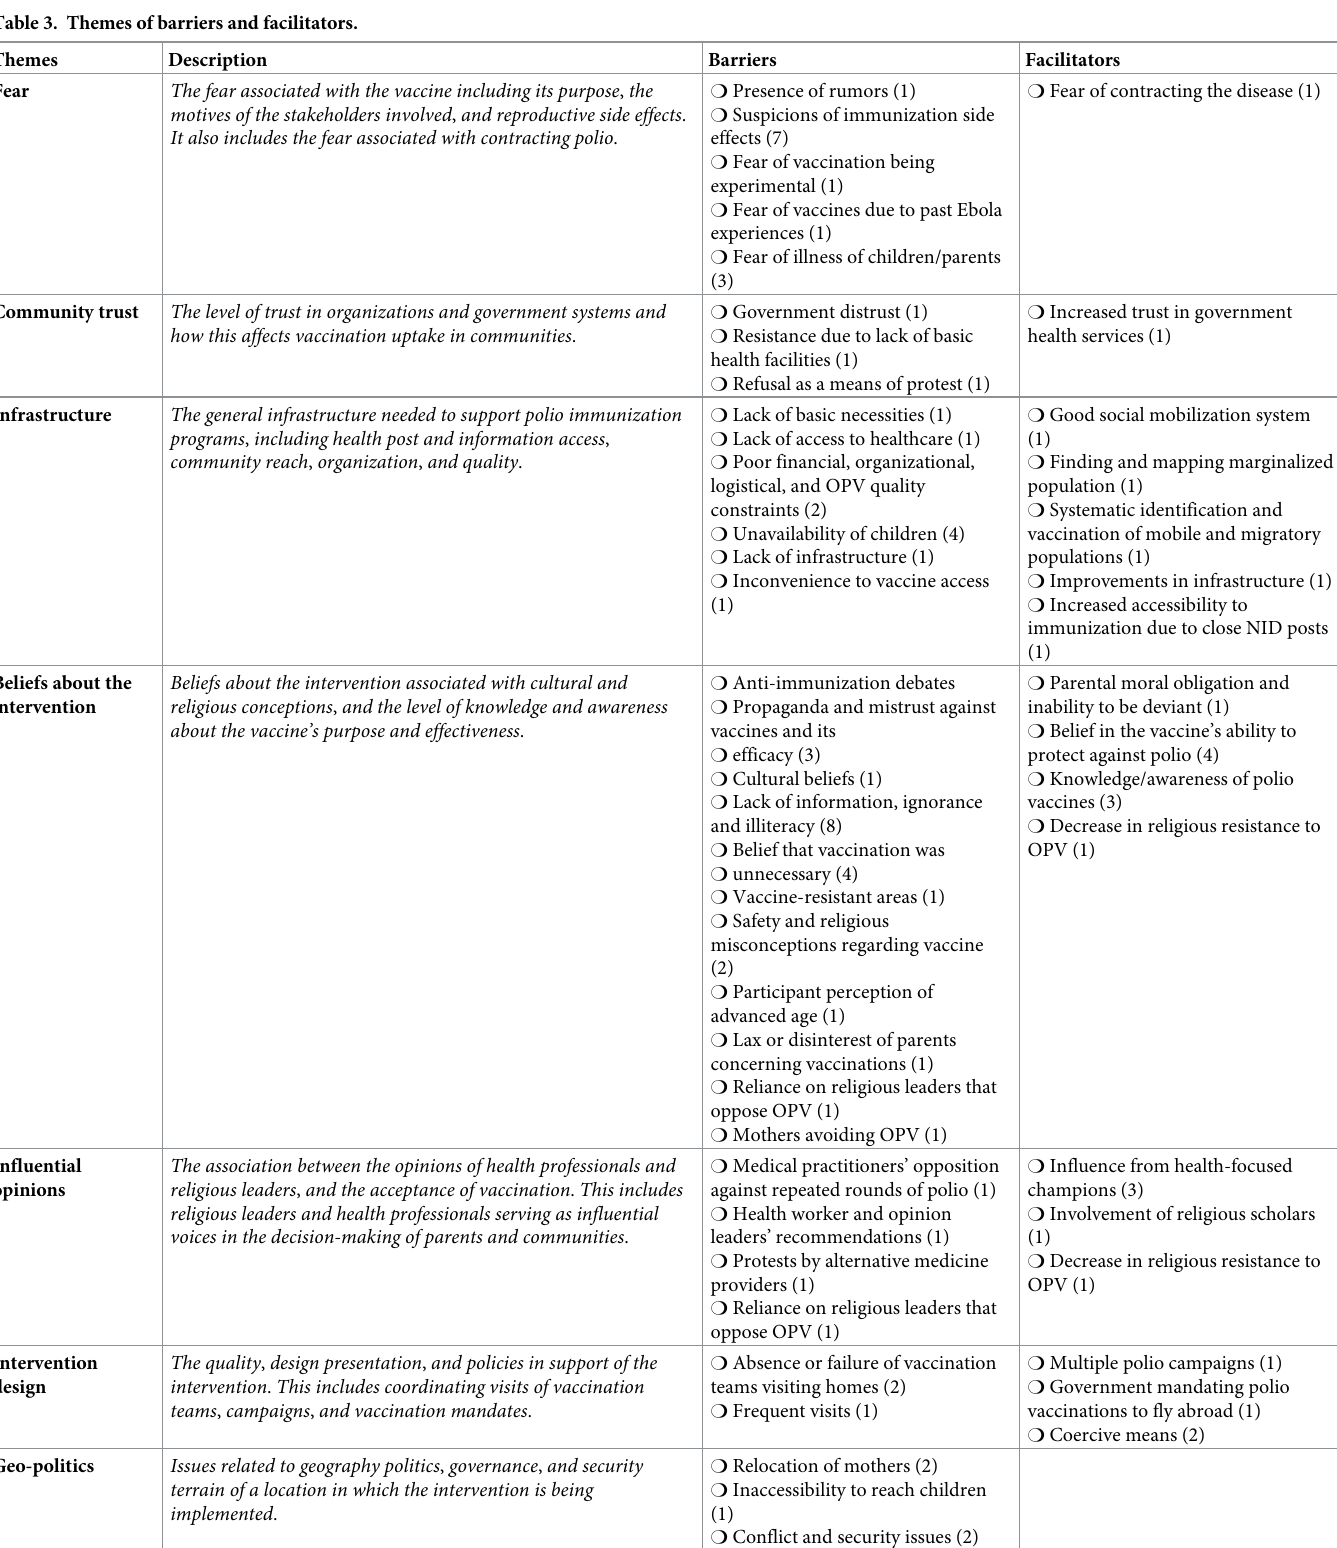
Table 3. Themes of barriers and